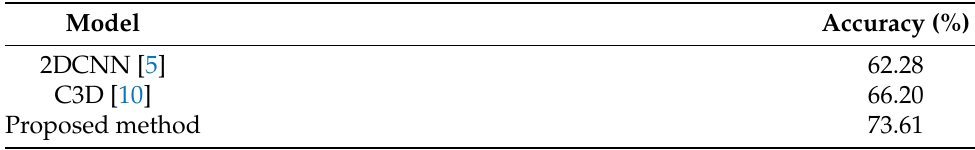
Table 4. Accuracy comparison in KTH